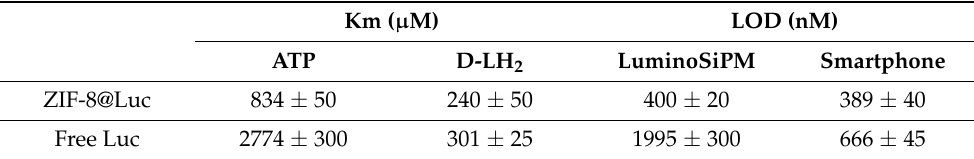
Table 2. Michaelis–Menten constants and limits of detection (LOD) obtained with ZIF-8@Luc paper sensor and free luciferase. Km was determined with a benchtop Table 1. Precision studies for paper biosensors obtained with different acquisition times (300, 600 and 1200 s).